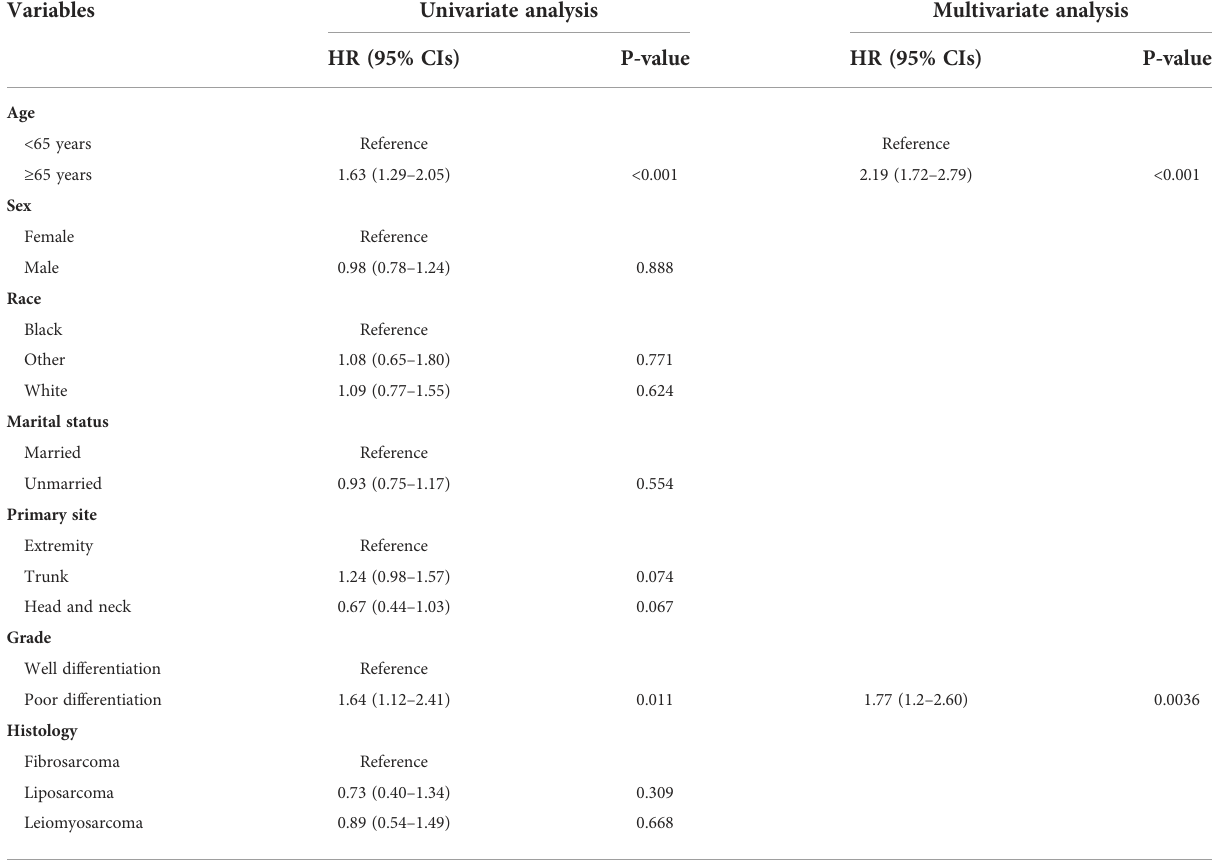
TABLE 6 Univariate and multivariate Cox regression analysis for identi fi cation independent prognostic factors for cancer-speci fi c survival in patients with soft tissue sarcoma with lymph node